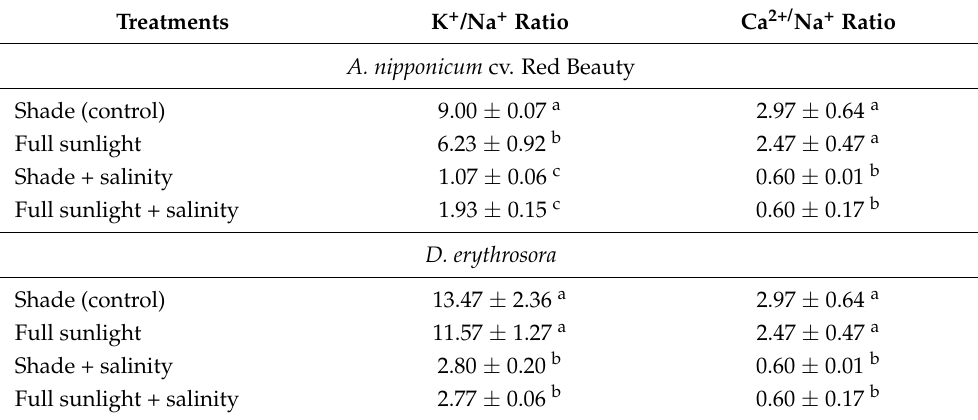
Table 2. Effect of abiotic stresses excess on K + /Na + and Ca 2+ /Na + ratios of two hardy ferns. Within a column means followed by the same lowercase letter are not significantly different at p ≤ 0.05 (ANOVA, Tukey’s HSD post hoc